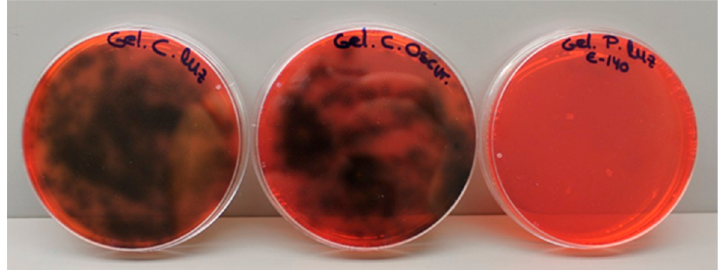
Figure 3. Microbial growth of L. monocytogenes . Left to right: control G film which had been